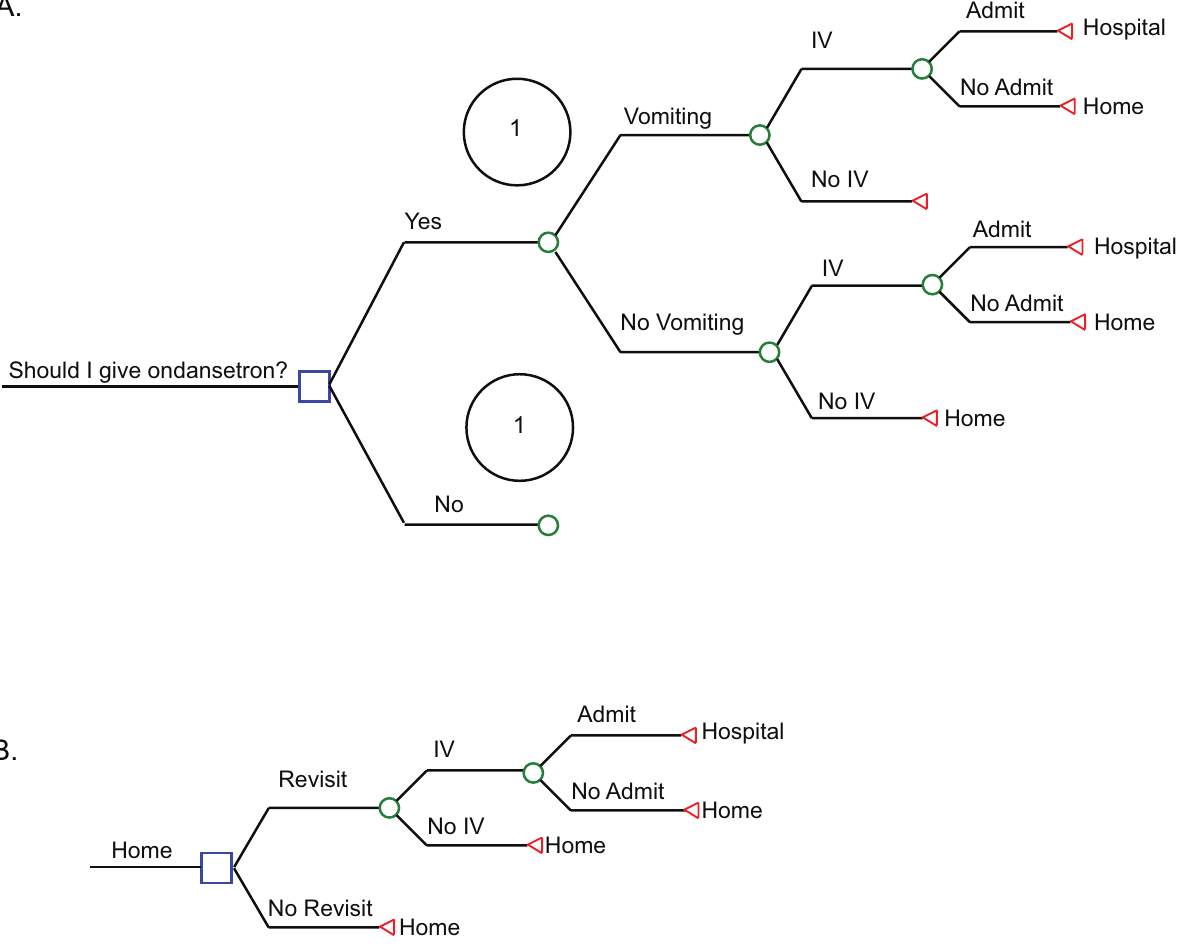
Figure1. Treestructureused inthe decision model. Thetree structure was toolargeto demonstrateusinga single figure andhasbeendivided up into two sections labeled (A) and (B). Entry into tree (A) requires that the child meet eligibility criteria (vomited on the day of presentation and evidence of dehydration). The two strategies evaluated are presented after the decision node, indicated by a square in (A). Each possible outcome (i.e., vomiting, intravenous rehydration) is presented on a tree branch after a chance node, shown as a circle on the tree. The complete tree is symmetrical beginning from the left of (A) and moving to the right, through (B) with the ‘‘yes’’ and ‘‘no’’ arms being identical as represented by the number 1. The costs and outcomes were entered at the payoff node, indicated by a triangle at the end of the models in both (A) and (B). An individual simulated patient can be followed through the tree by starting with the treatment choice in (A) and moving through the tree. The patient will have the potential to develop an outcome on the basis of the probabilities present at each chance node and are presented in Table 1. At the end of the tree, the total cost for that simulated patient is calculated on the basis of the treatment received and the outcomes experienced. Yes implies ondansetron is administered to all in addition to ORT; no implies standard of care (ORT) is administered but ondansetron is not administered. IV,